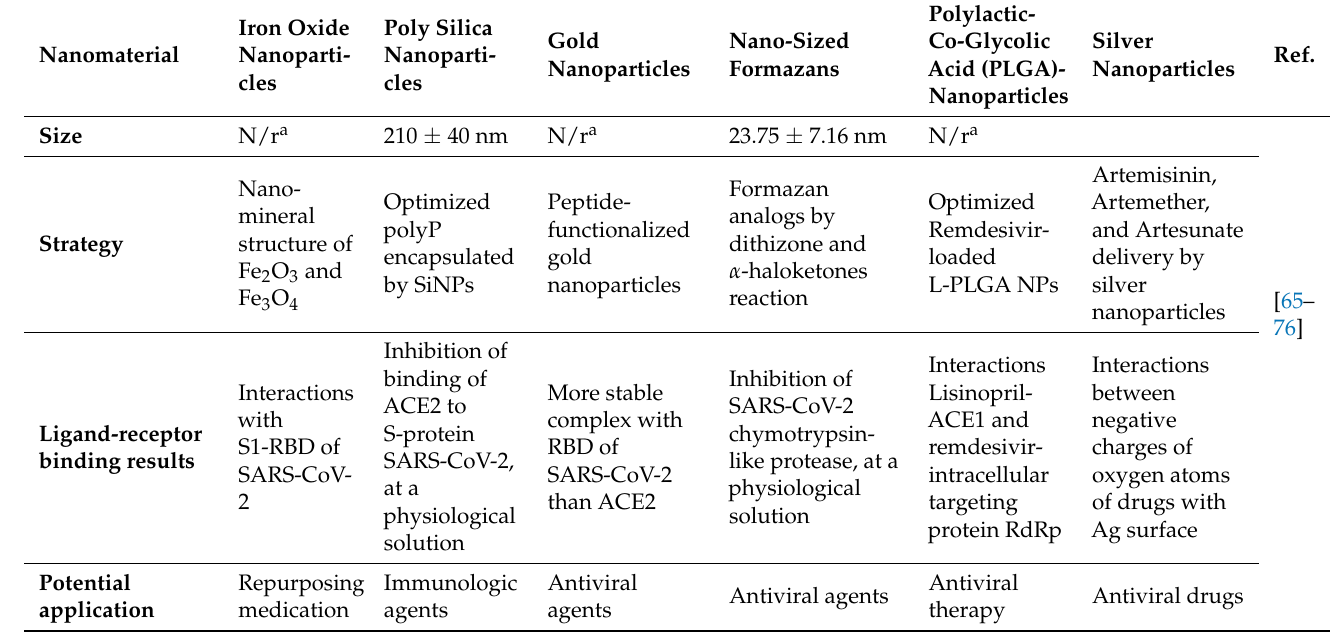
Table 5. Nanomaterial’s approach against SARS-CoV-2.